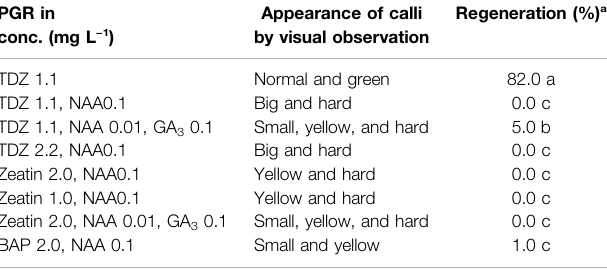
TABLE 4 | Effect of PGRs in SIM medium on shoot regeneration of fi eld cress. PGR in conc. (mg L − 1